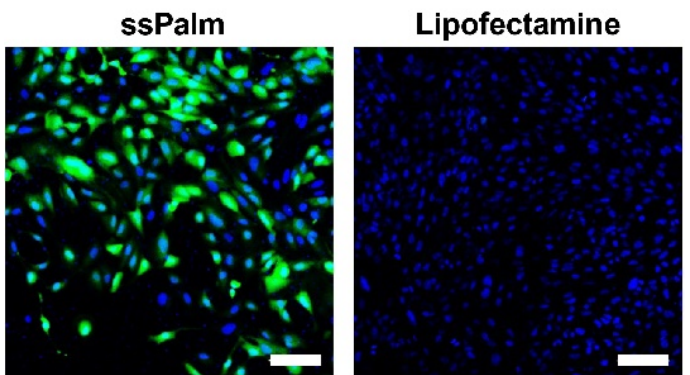
Figure 1. GFP expression by mRNA transfection using the ssPalm LNP or LFN. The GFP expression in hCMEC/D3 observed after mRNA transfection at a concentration of 0.4 μg/mL. Nuclei (Hoechst33342) and GFP were depicted in blue and green, respectively. Scale bars: 100 μm.